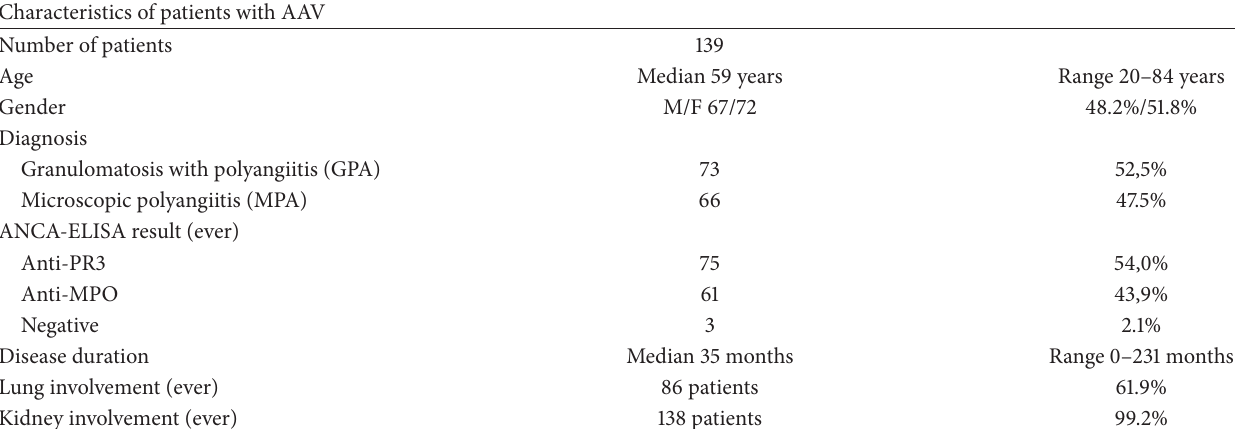
Table 1: Basic clinical characteristics of patients with AAV.